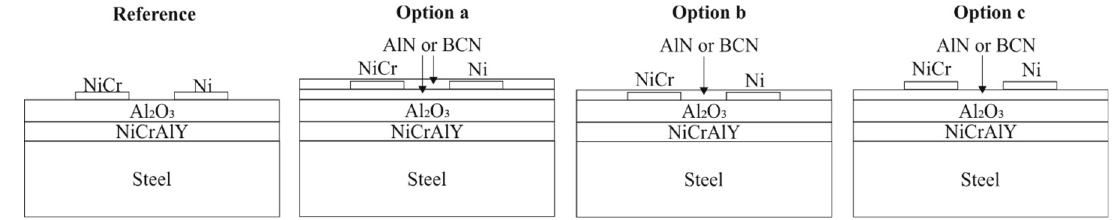
Figure 1. Multilayer design of Ni/NiCr thin film thermocouples with and without nitride top and bottom layers.